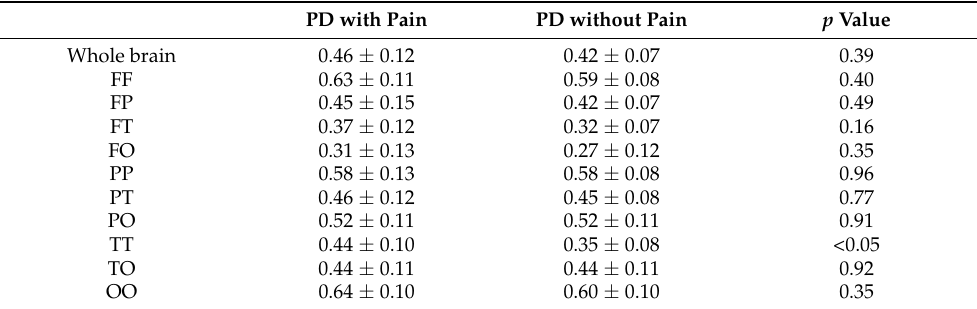
Table 2. Comparison of the whole-brain and regional coherence values in the alpha band between patients with PD, with and without pain.